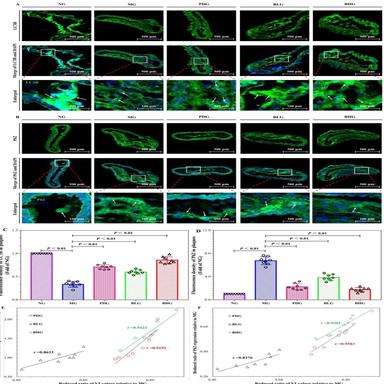
Representative immunofluorescence images of the aortic sections stained with LC3B (A) and P62 (B) antibodies. Fluorescence density ratio of LC3B (C) or P62 (D) protein in plaques (Fold of NG). Pearson correlation analysis between the increased ratio of LC3B expression (E) or reduced ratio of P62 expression (F) (related to MG) and the reduced ratio of VI values (related to MG).